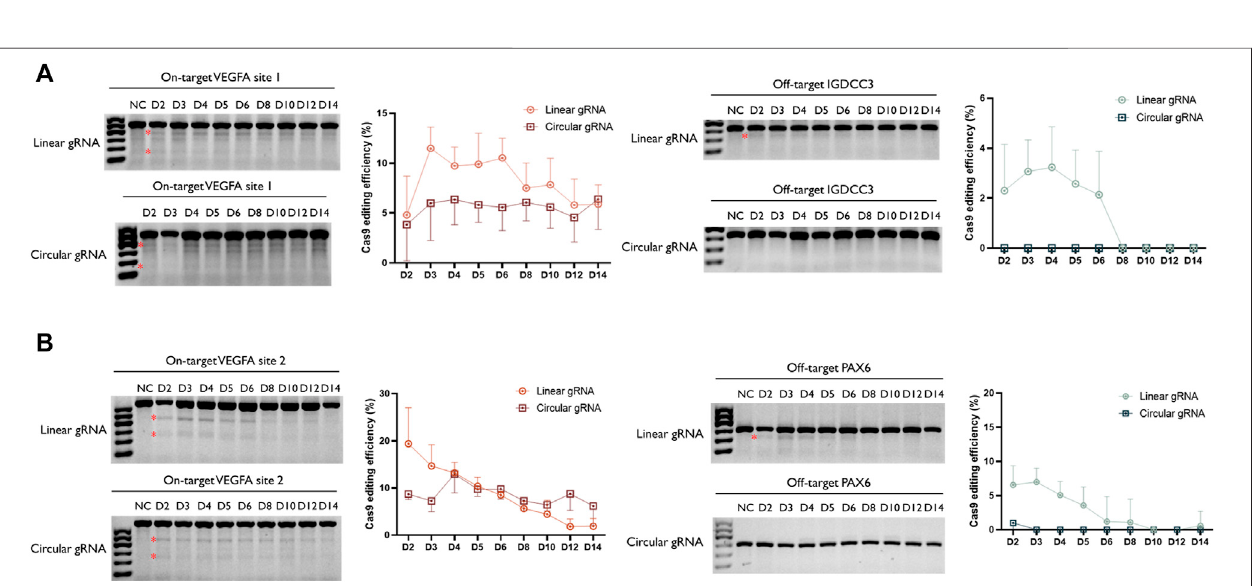
FIGURE 4 | Enhanced stability ofcirculargRNAguidedCas9cleavage. Representative T7EI assay for visualization ofVEGFA1 (A) and VEGFA2 (B) on- and off-target editing.ThegenomicDNAwascollectedfromthetransientlytransfectedsamplesfromday2today14.Thesemi-quantitativeanalysisoftheT7E1assayfurthercon fi rmedthe ability of both gRNAs to facilitate the Cas9 cleavage. In addition, through the time-course assessment, a more stable performance was observed in the group of circular gRNA. The relative Cas9 editing ef fi ciencies were standardised to the no gRNA negative control group. Data were means ± SD from three independent experiments.